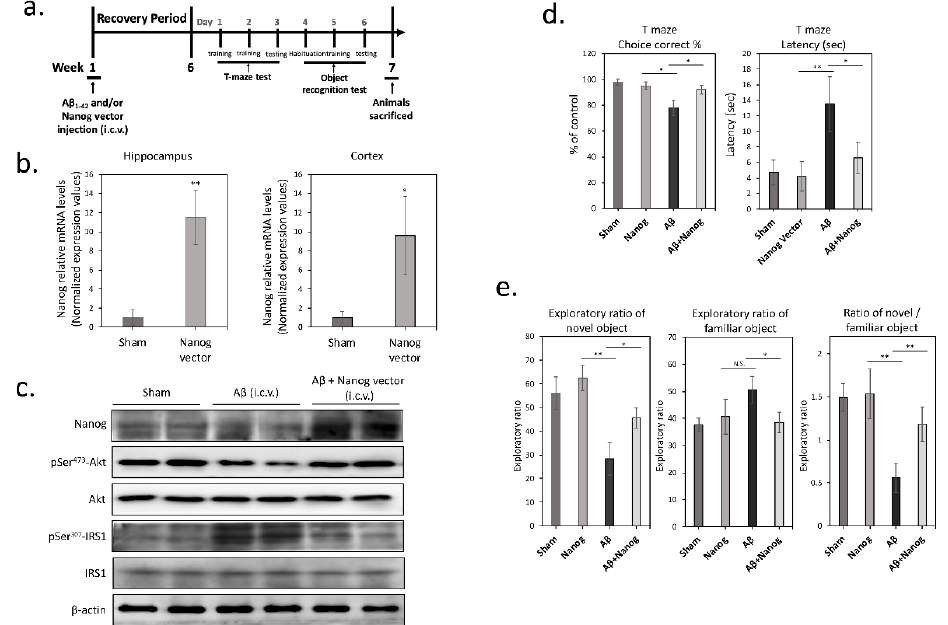
Figure 4. Upregulation of Nanog in rat brains improves working and recognition memory deficits induced by A β . ( a ) The experimental protocol of the behavioral tests; ( b ) six weeks after stereotaxical injection, mRNA levels of Nanog were measured by performing qPCR. Nanog mRNA levels in hippocampus and cortex were significantly increased in Nanog-overexpressed group; ( c ) western blotting revealed that overexpression of Nanog markedly inhibited IRS-1 Ser 307 and restored Akt Ser 473 phosphorylation in rat hippocampus; ( d ) behavioral testing was performed at 6 weeks after stereotaxical surgery. Results showed the percentage of correct responses to select the arm with the reward and time latency to finish each session for the T-maze test; ( e ) percentage of time spent exploring new or old objects in object recognition test. Upregulation of Nanog in the brain significantly increased the ratio of novel / familiar object exploring time compared to Aβ -injected group. Values were expressed as means ± SEM from at least three independent experiments. The significance of di ff erences was determined through unpaired Student’s t- test or multiple comparisons with Dunnett’s post hoc test at * p < 0.05 and ** p < 0.01 compared with the indicated groups. N.S.: not